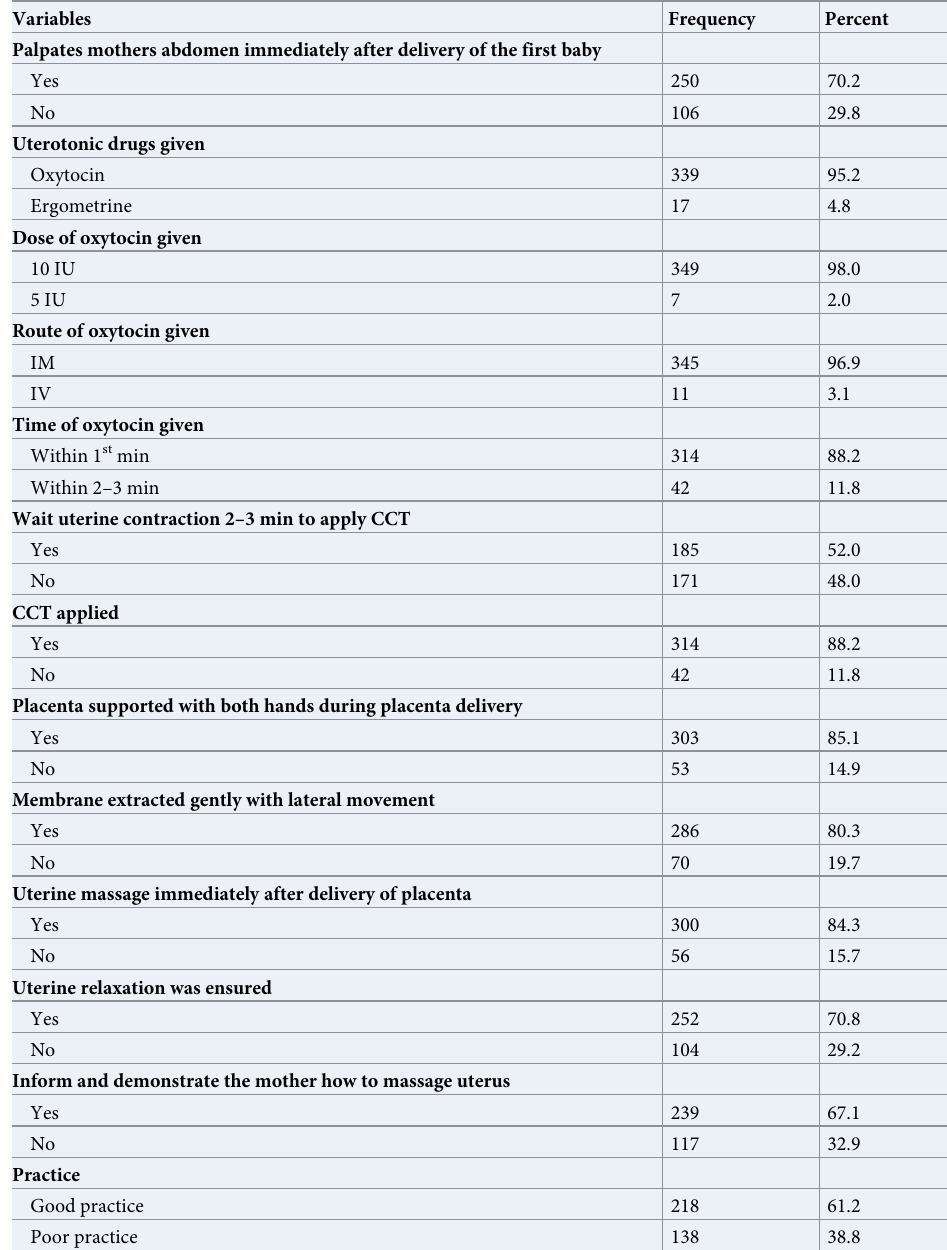
Table 4. Practices of the obstetric care